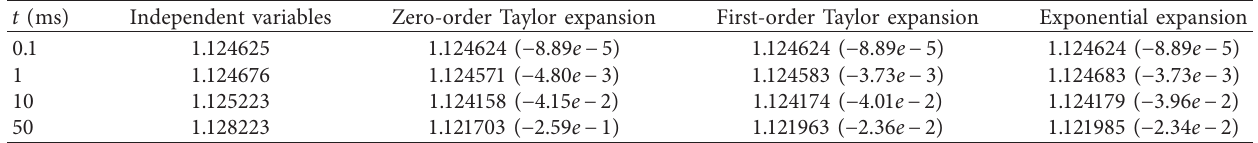
Table 5: TWIGL relative power transient reference problem ramp reactivity insertion at